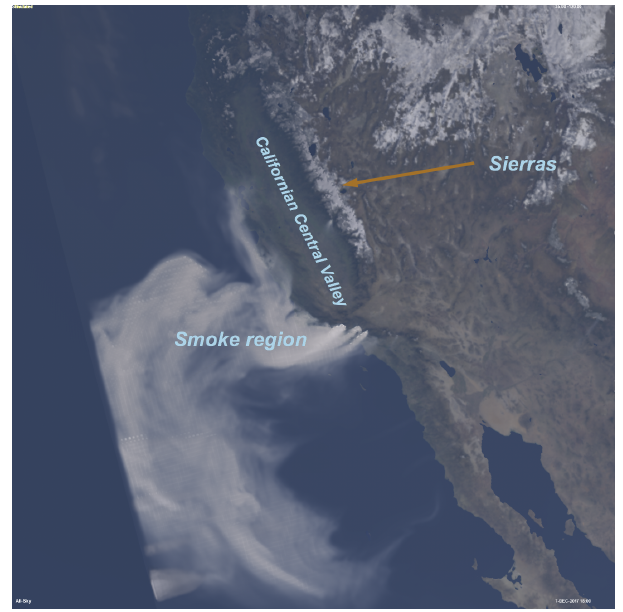
Figure 6. NAVGEM view from space using aerosols only. The per- spective point is 1 . 5 × 10 6 km